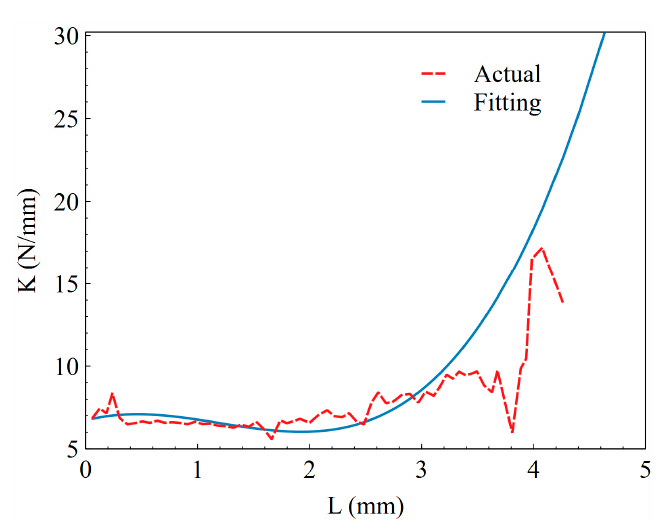
Figure 5. Stiffness–displacement curve of magnetic zero stiffness mechanism.